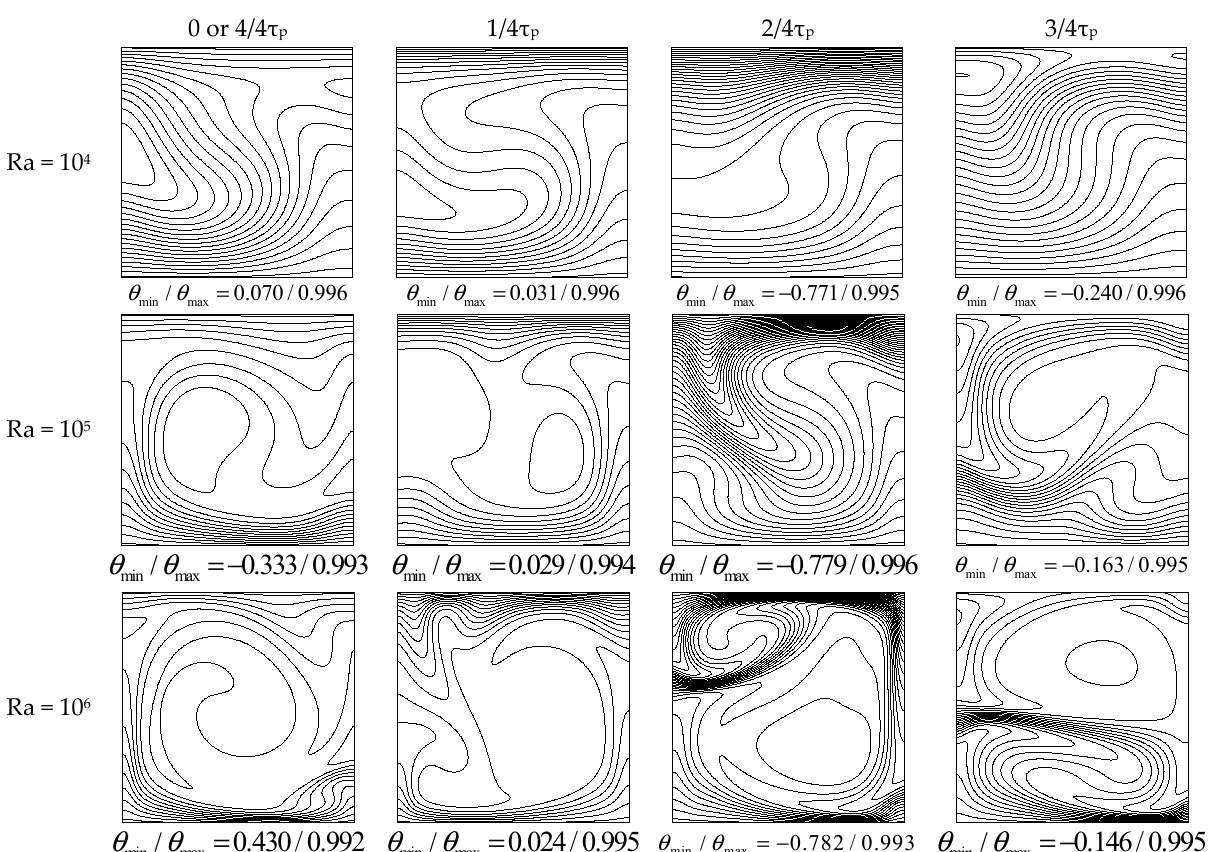
Figure 6. Evolution of isotherms over a period as a function of the Rayleigh number (Amp = 0.2 and |f| = 0.33 × 10 − 4 ).